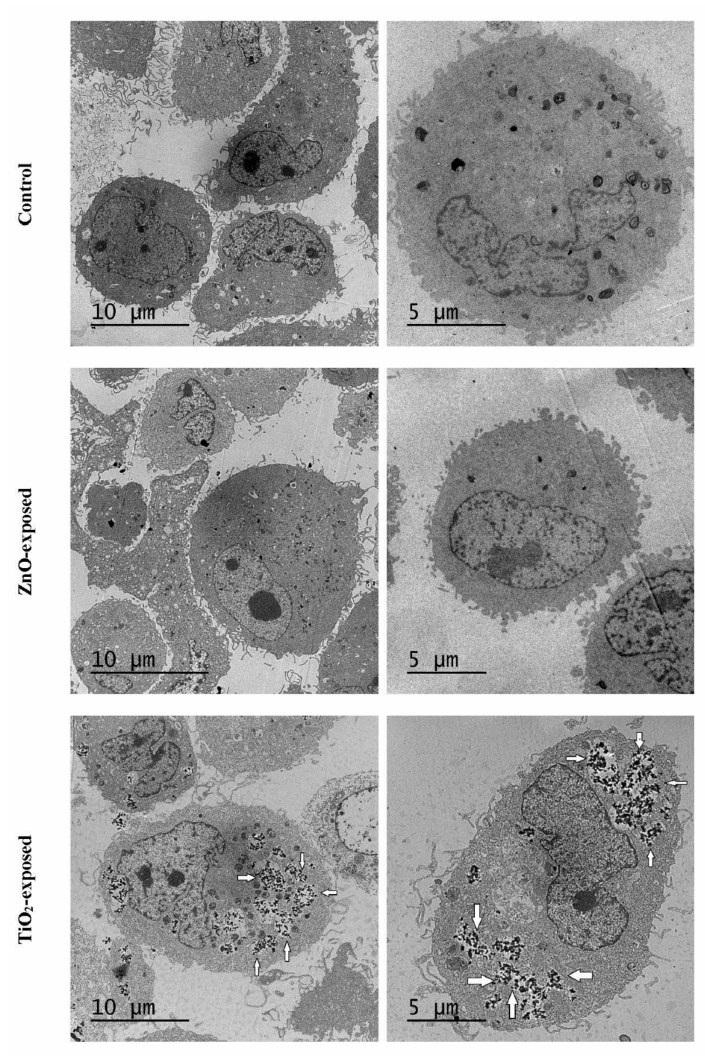
Figure 4. T98G human glioblastoma cells visualized by TEM. Cells were exposed to 20 µ g/mL of TiO 2 -NPs or 5 µ g ZnO-NPs for 72 h, as described in Section 4.4, and then prepared for TEM as described in Section 4.7. A second independent culture yielded similar results. White arrows denote clusters of TiO 2 -NPs in the areas of apparent cytoplasmic